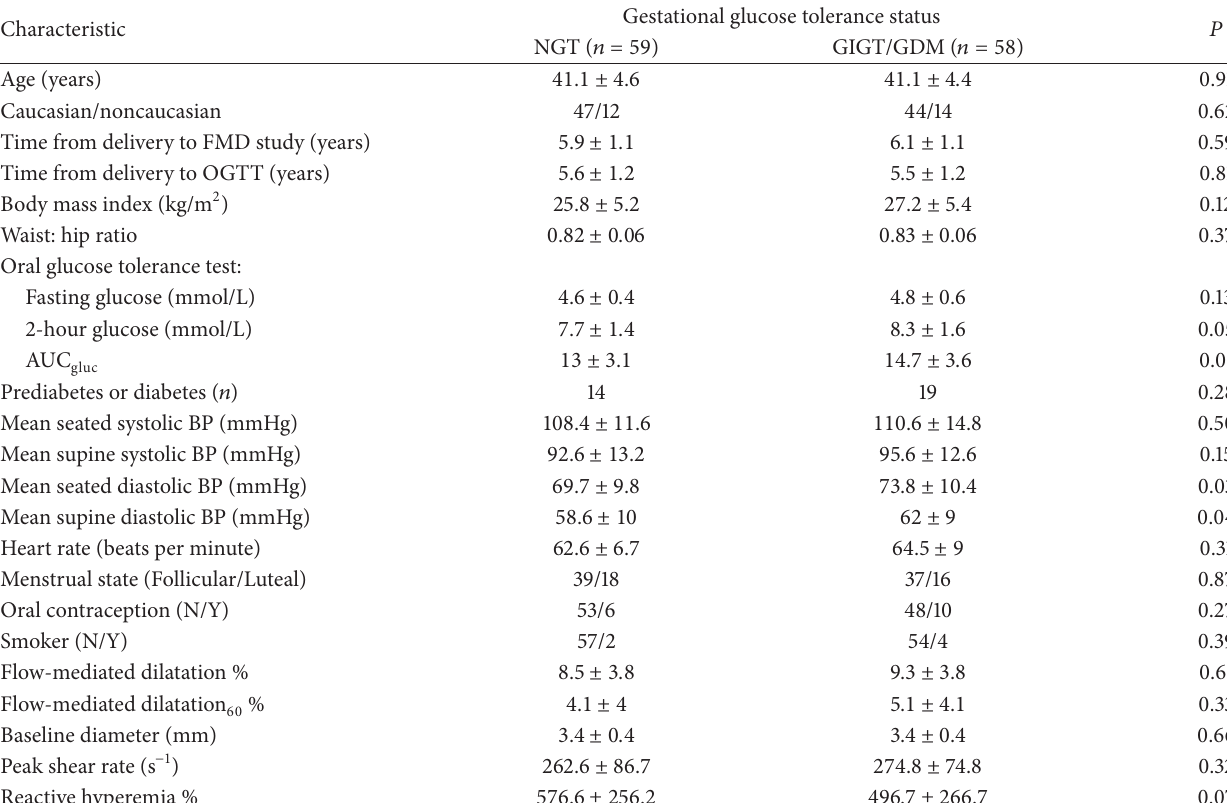
Table 1: Characteristics of study population stratified by glucose tolerance status in pregnancy.